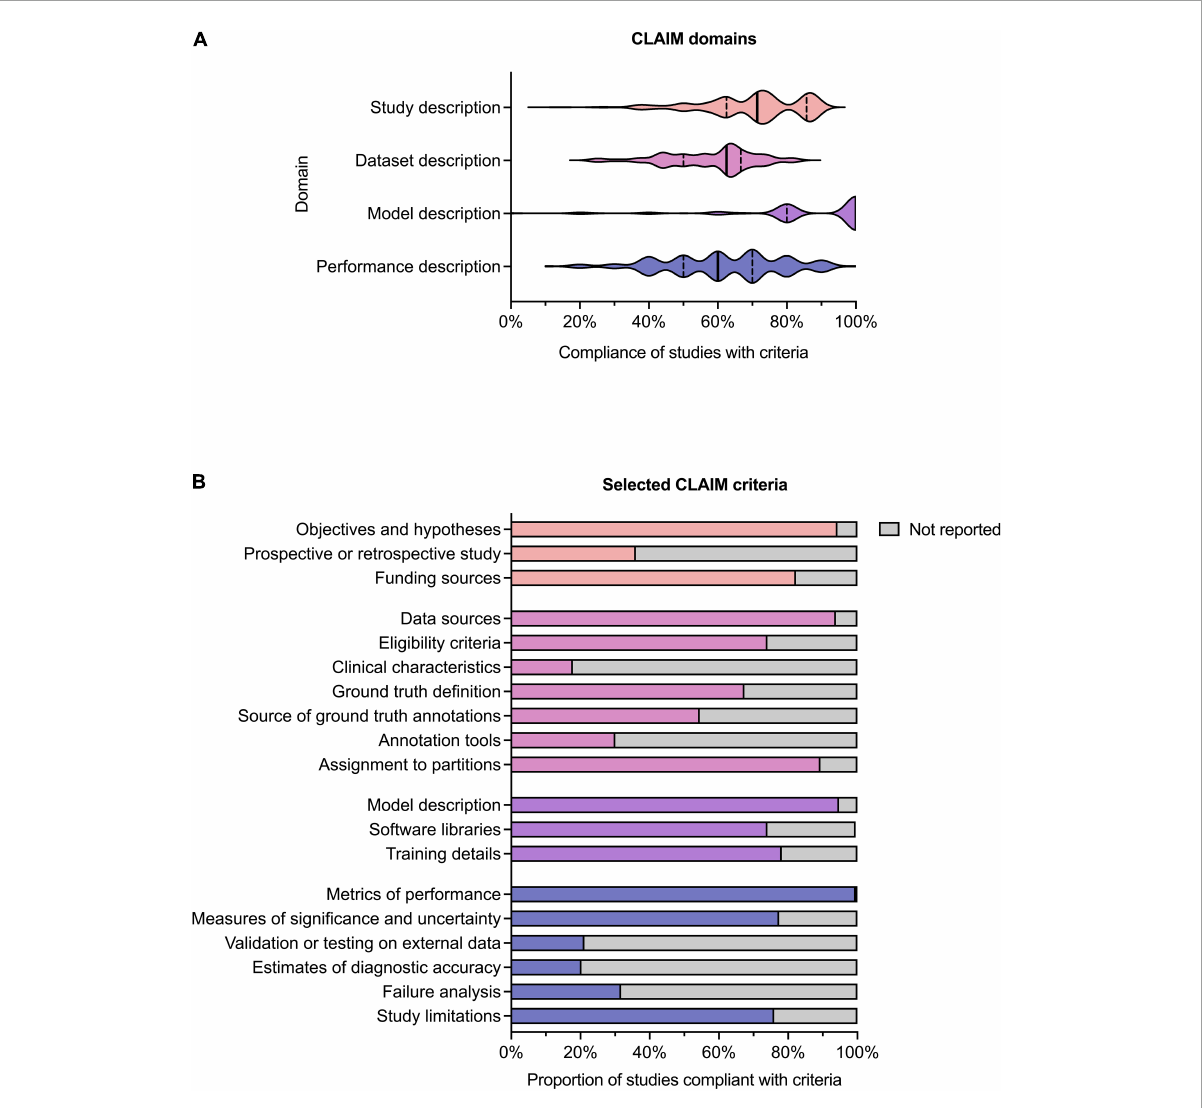
FIGURE4 Compliance with CLAIM. (A) Violin plot showing compliance of the 209 included studies with the CLAIM criteria, grouped into domains of study, dataset, model and performance description. Median ( solid line ) and 1st and 3rd quartile ( dashed lines ) values are indicated. (B) Proportion of studies compliant with selected CLAIM criteria, grouped by domain (the titles of the individual criteria have been shortened for ease of reading).